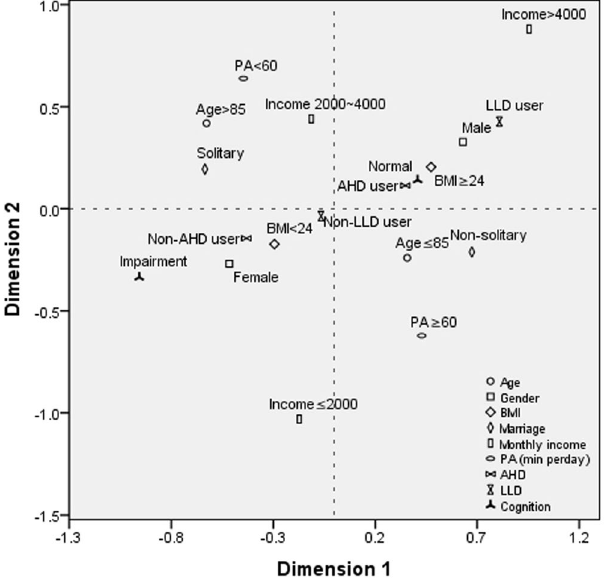
Figure 2. Multiple correspondence analysis (MCA) plot. Risk factors were presented as icons and a brief description was labeled near the icon indicating a specific category of risk factors. To interpret MCA plot, icons closed together in the same quadrants along the similar direction from centroid would be indicative of possible associations. BMI, body mass index; PA, physical activity; AHD, antihypertensive drugs; LLD, lipid lowering